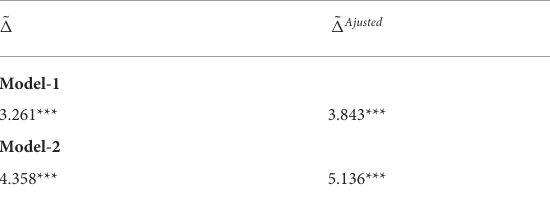
TABLE 2 Slope heterogeneity.